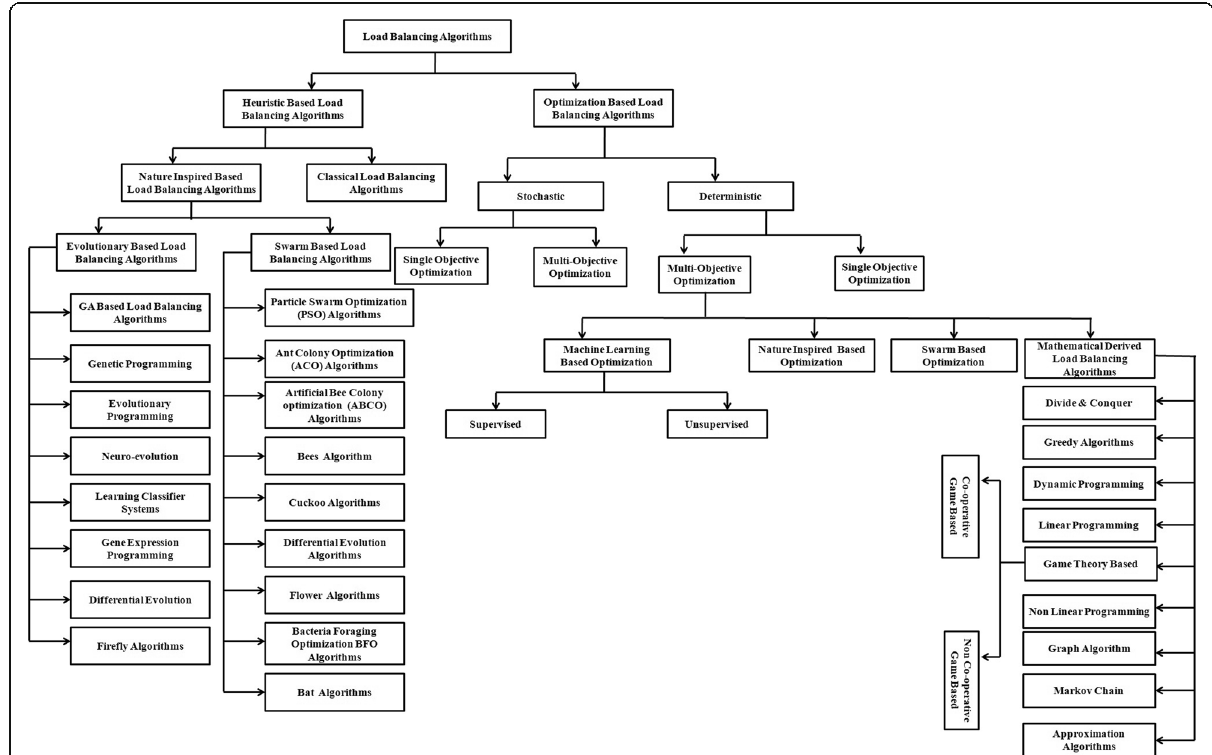
Fig. 6 Load balancing algorithms on the basis of